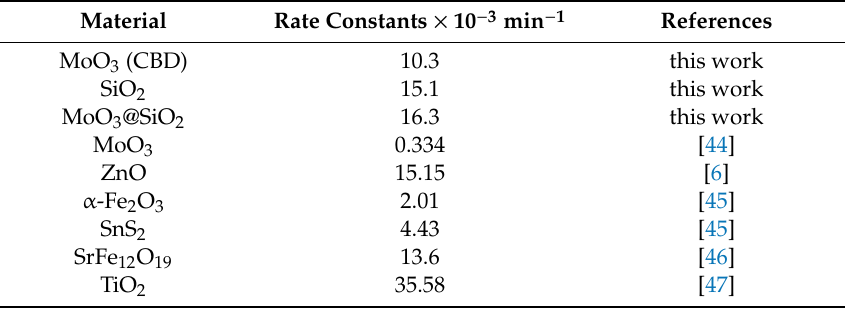
Table 1. Comparative rate constants for different photocatalysts, including our work.